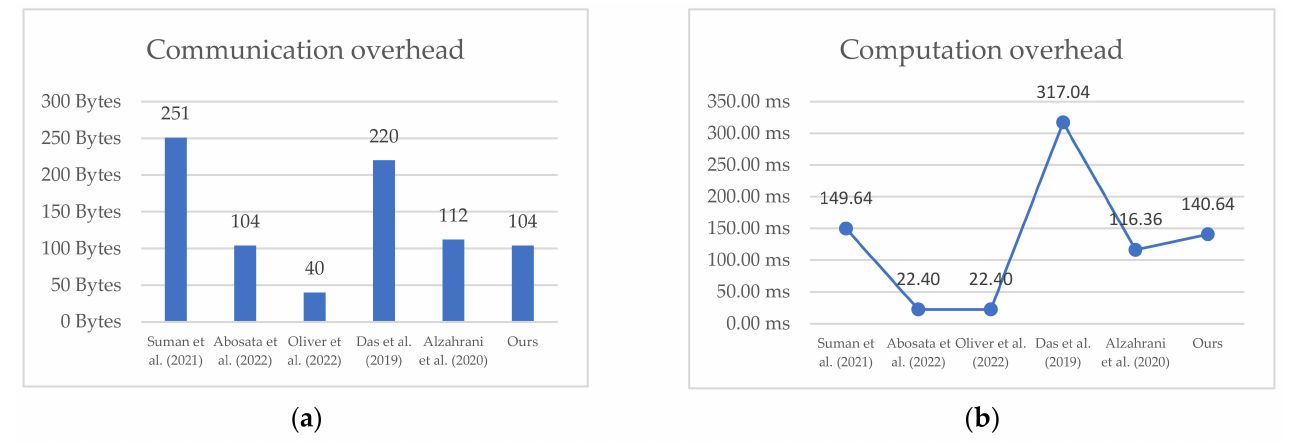
Figure 19. ( a ) Comparison of communication overheads; ( b ) Comparison of computation over- heads